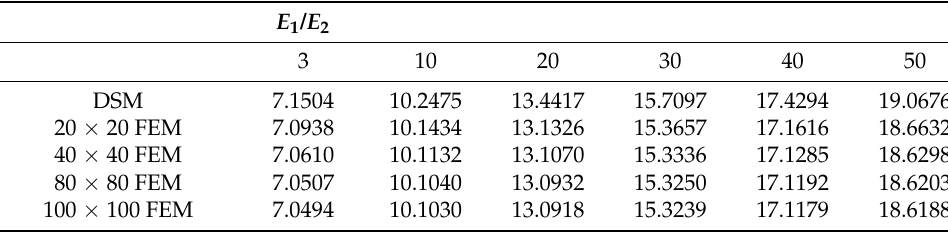
Table 2. Obtained results for the test accuracy of the finite element mesh.